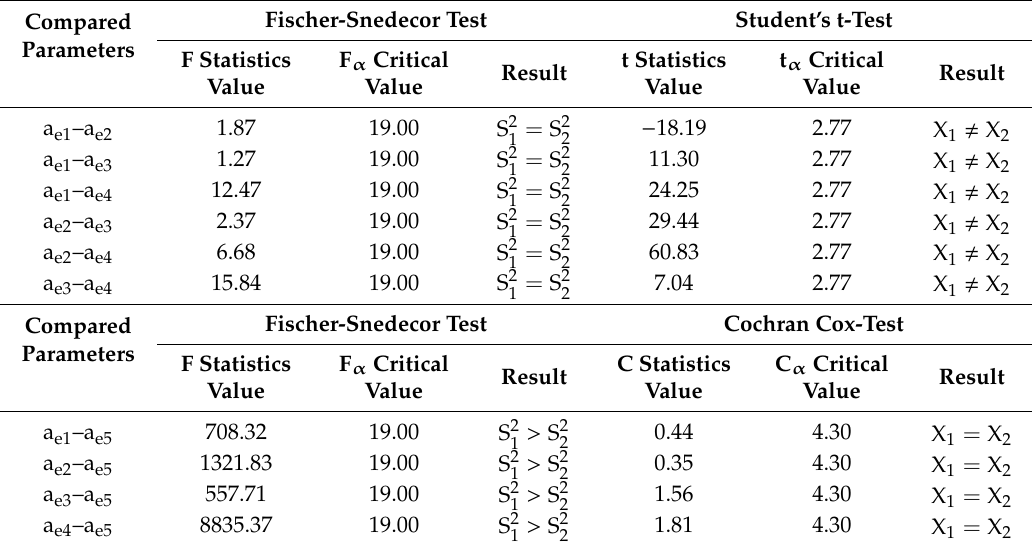
Table 13. Results of statistical analysis for a e variable during milling from composite layer (CFRP / Al).